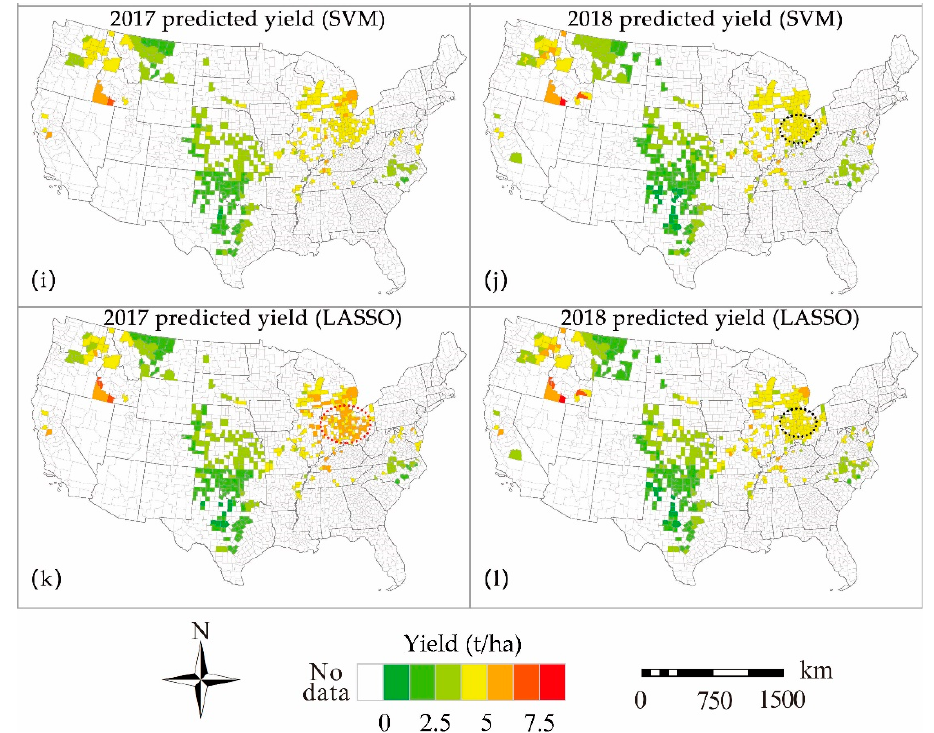
Figure 4. The spatial patterns of the prediction (the black ellipses represent the underestimated regions. The red ellipse represents the overestimated region) .